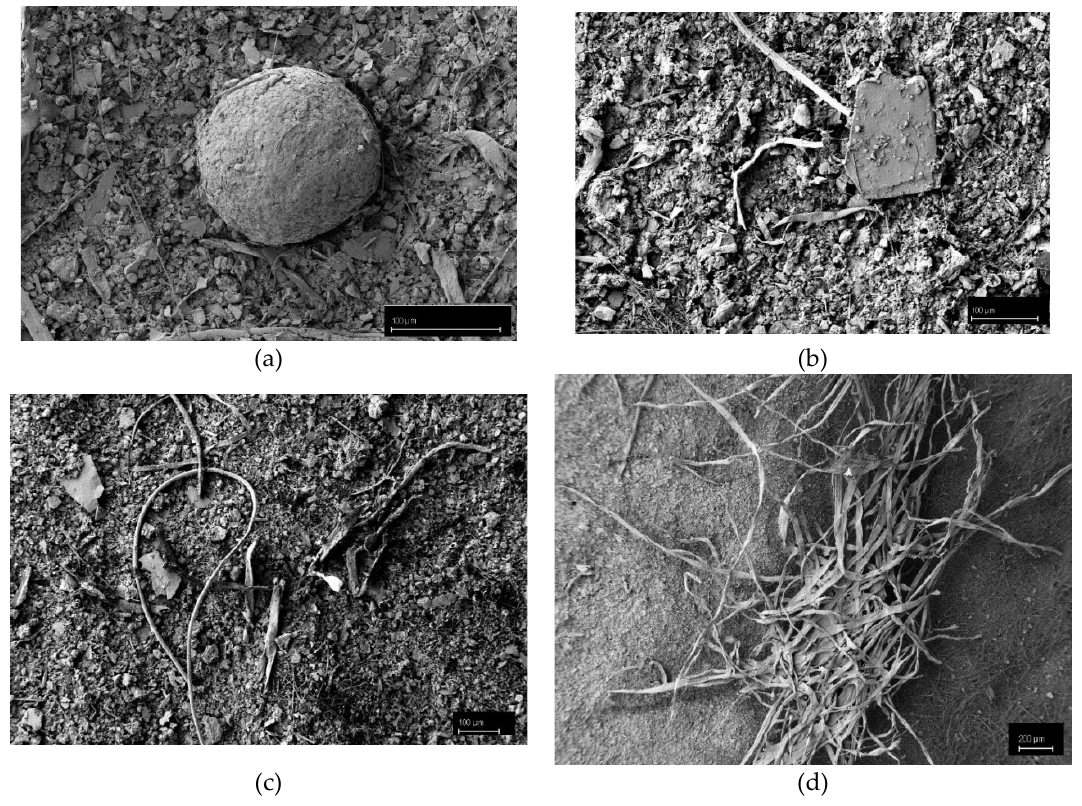
Figure 6. Micrography of the microplastics found. ( a ) Microsphere; ( b ) PET fragment; ( c ) fiber from clothing; ( d ) nonwoven fiber from packaging materials.